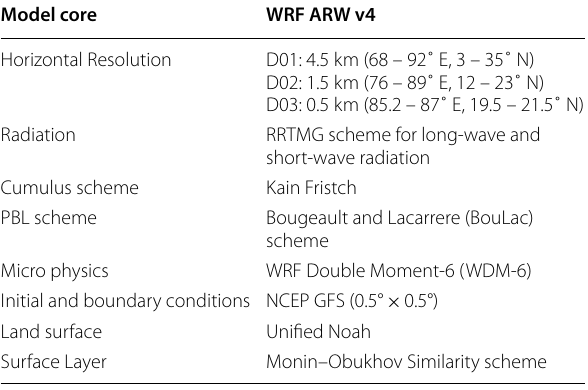
Table 1 Model configuration Model